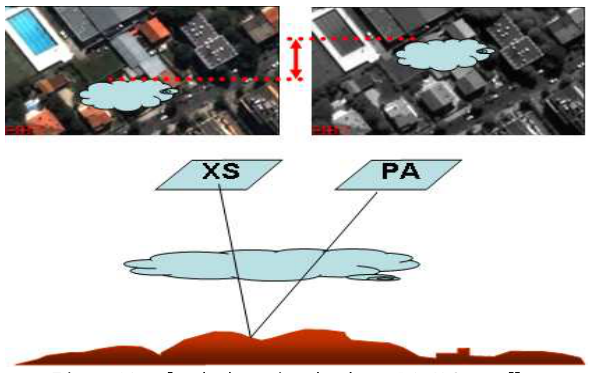
Figure 13 : clouds detection thanks to PA-XS parallax